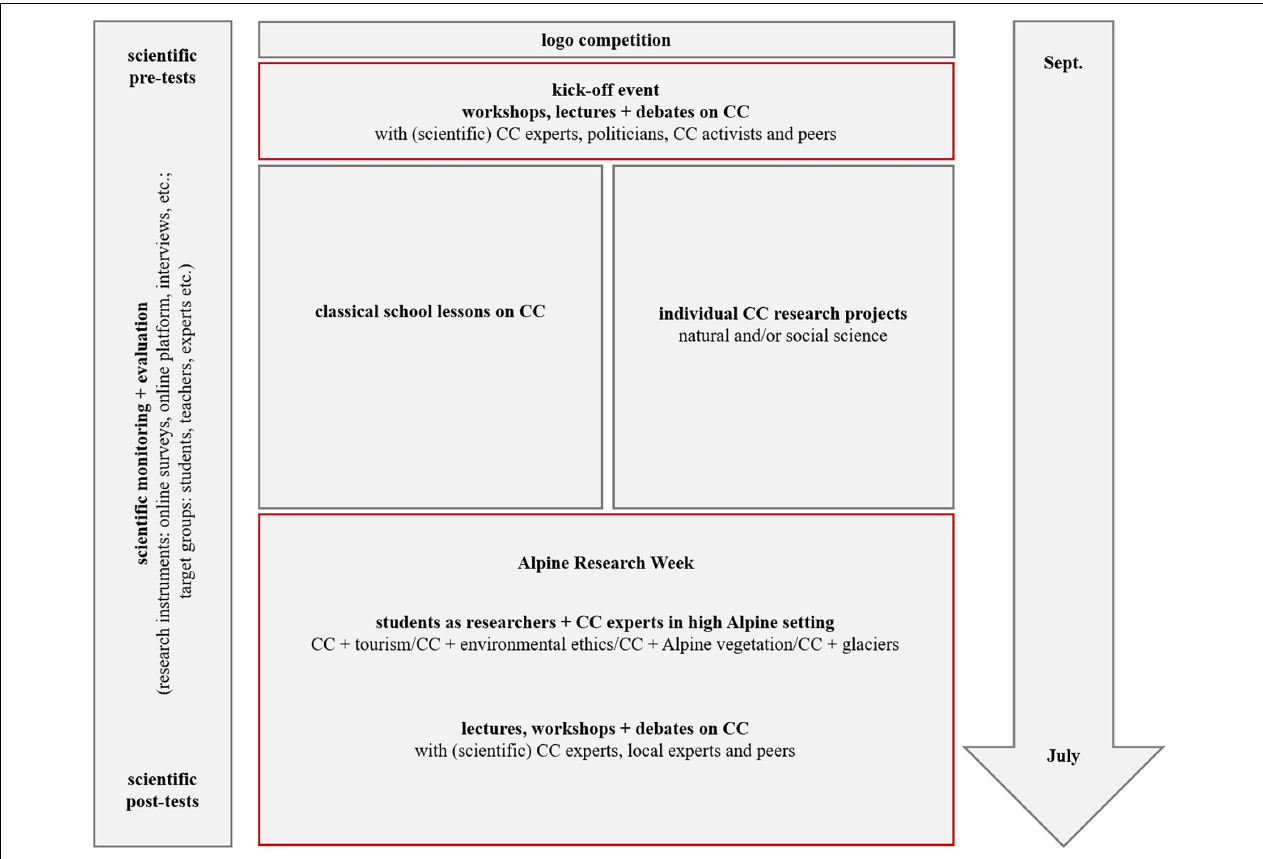
FIGURE 1 | Modules of the Austrian transdisciplinary education (TE) project k.i.d.Z.21 , with the red-framed modules as transdisciplinary modules [source: modified according to Kubisch et al. (2021b,